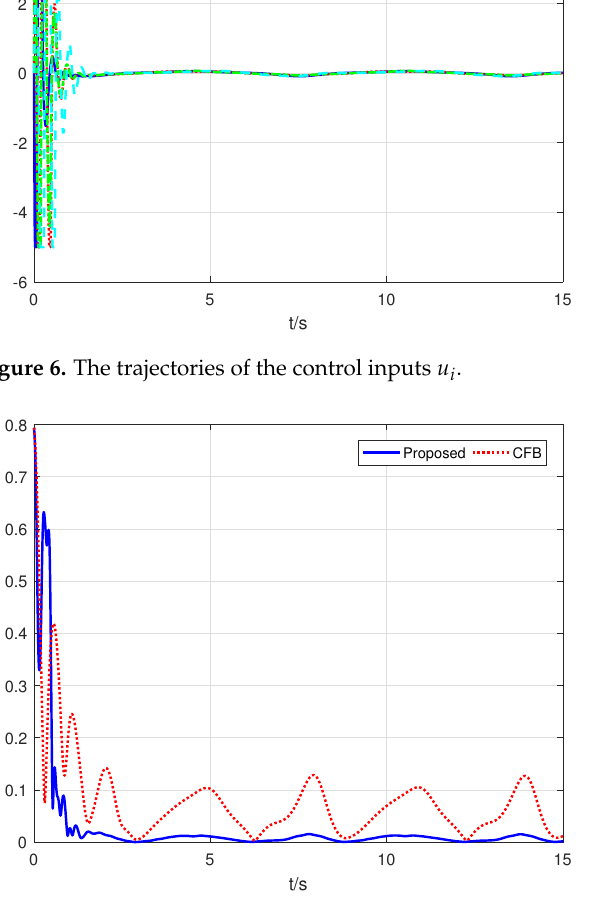
Figure 7. The trajectories of the OTE with different control algorithms. Table 1. Performance